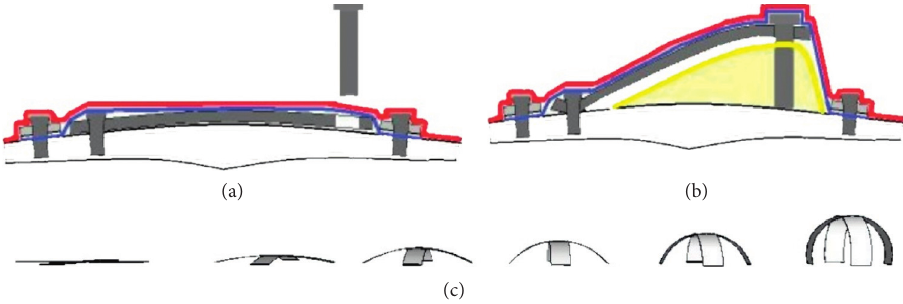
Figure 3: Illustration showing the mode of action of the expansible guided bone regeneration (EGBR) and smart guided bone regeneration (SGBR) devices. (a) The EGBR device is inserted in the calvarium site without activation. (b) The activation screw is inserted 1 week after EGBR device insertion. (c) The SGBR device is inserted in a flat unactivated state, and then, it becomes activated to maximum designed